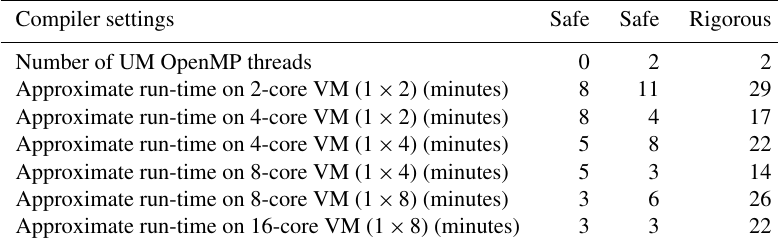
Table 4. Approximate timings for different UKCA configurations on the VM at UM version 11.0. The compiler settings are listed in detail in Table